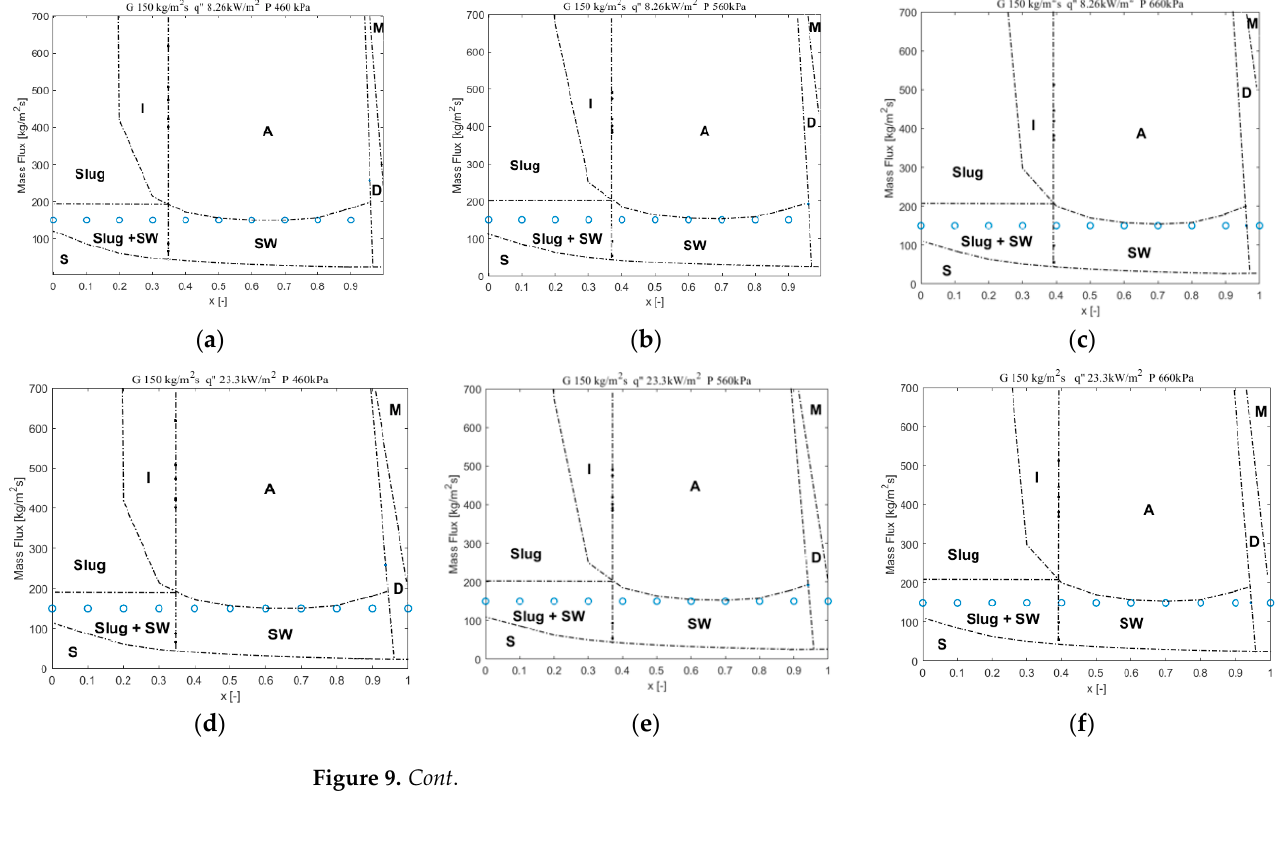
Figure 8. Effect of saturation pressure on heat transfer coefficient for mass flux of 300 kg/m 2 s and heat flux of 23.3 kW/m 2 .